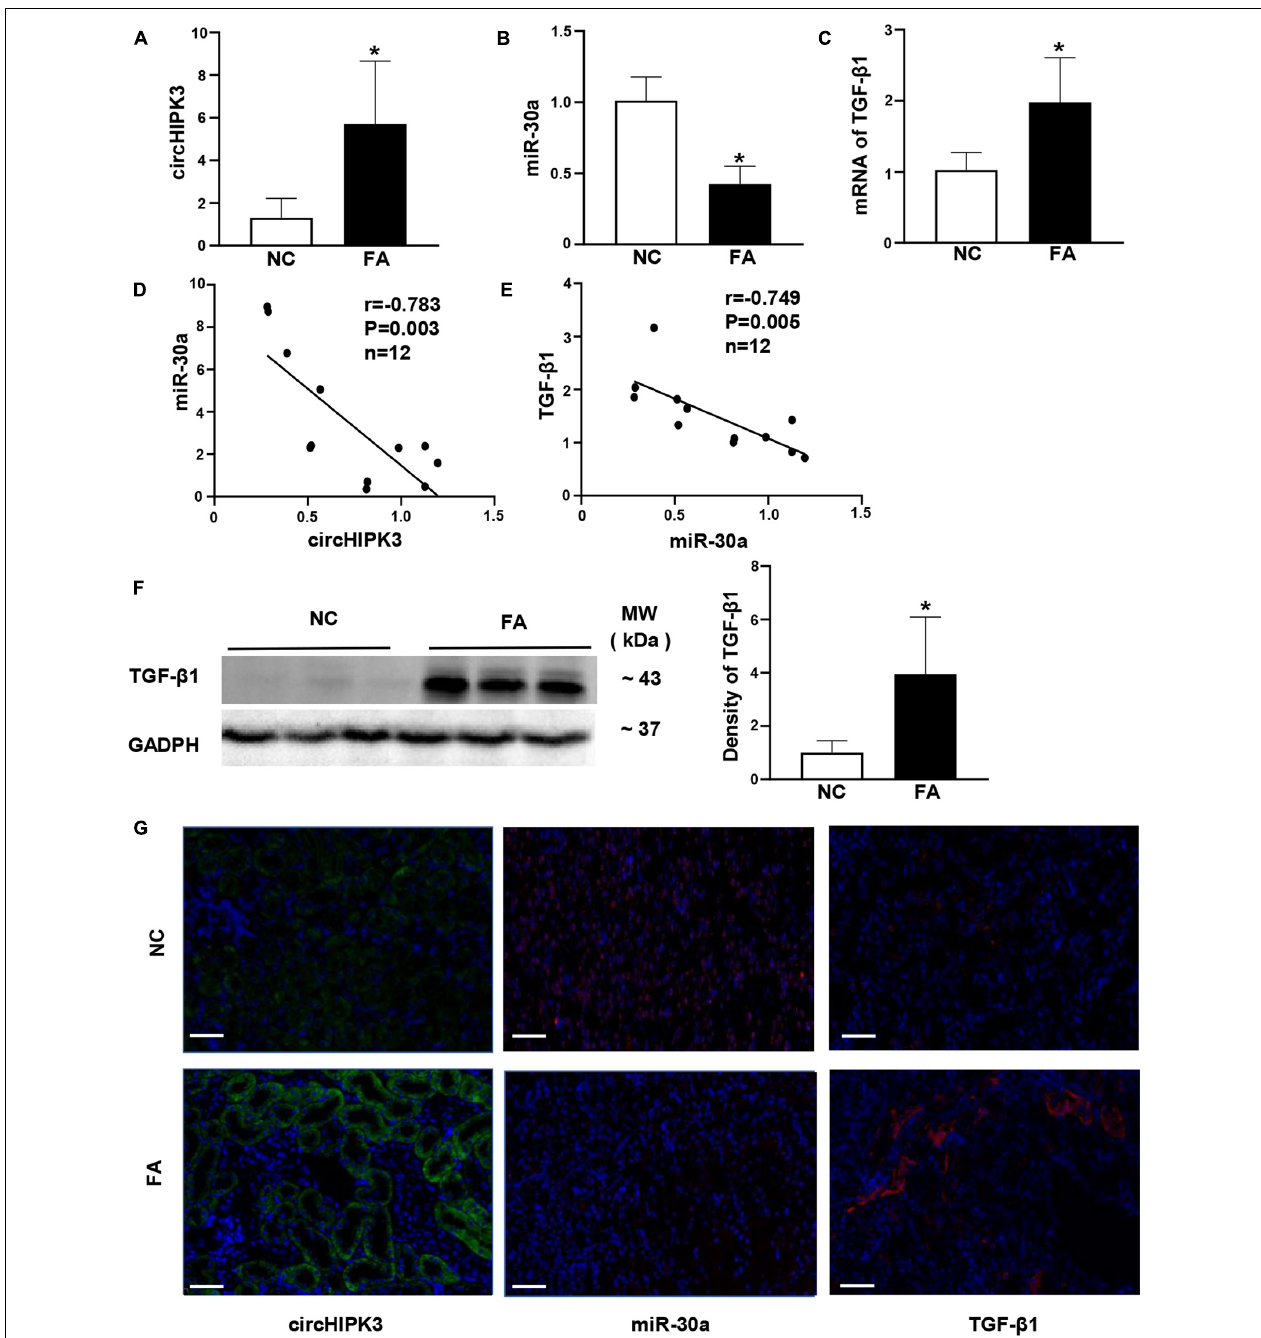
FIGURE 2 | Expression of renal circHIPK3/miR-30a/transforming growth factor beta-1 (TGF- β 1) in FA-induced renal tubulointerstitial fibrosis in mice. (A–C) circHIPK3, miR-30a, and TGF- β 1 on qPCR. (D,E) The correlation between renal circHIPK3 and miR-30a as well as miR-30a and TGF- β 1. (F) TGF- β 1 on immunoblotting and semi-quantitative analysis. (G) circHIPK3 and miR-30a on fluorescence in situ hybridization (FISH) as well as TGF- β 1 on immunofluorescence staining. n = 6 in each group, * p < 0.05, FA vs. NC, magnification 200 × , bar scale: 50 µ m. FA, folic acid; RIF, renal tubulointerstitial fibrosis.